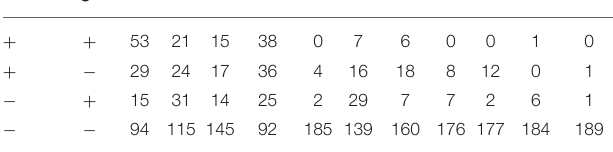
the condition is absent. Health condition abbreviations are introduced in the caption of Table 1 . Each column diagnoses the same sample of 191 colonies.